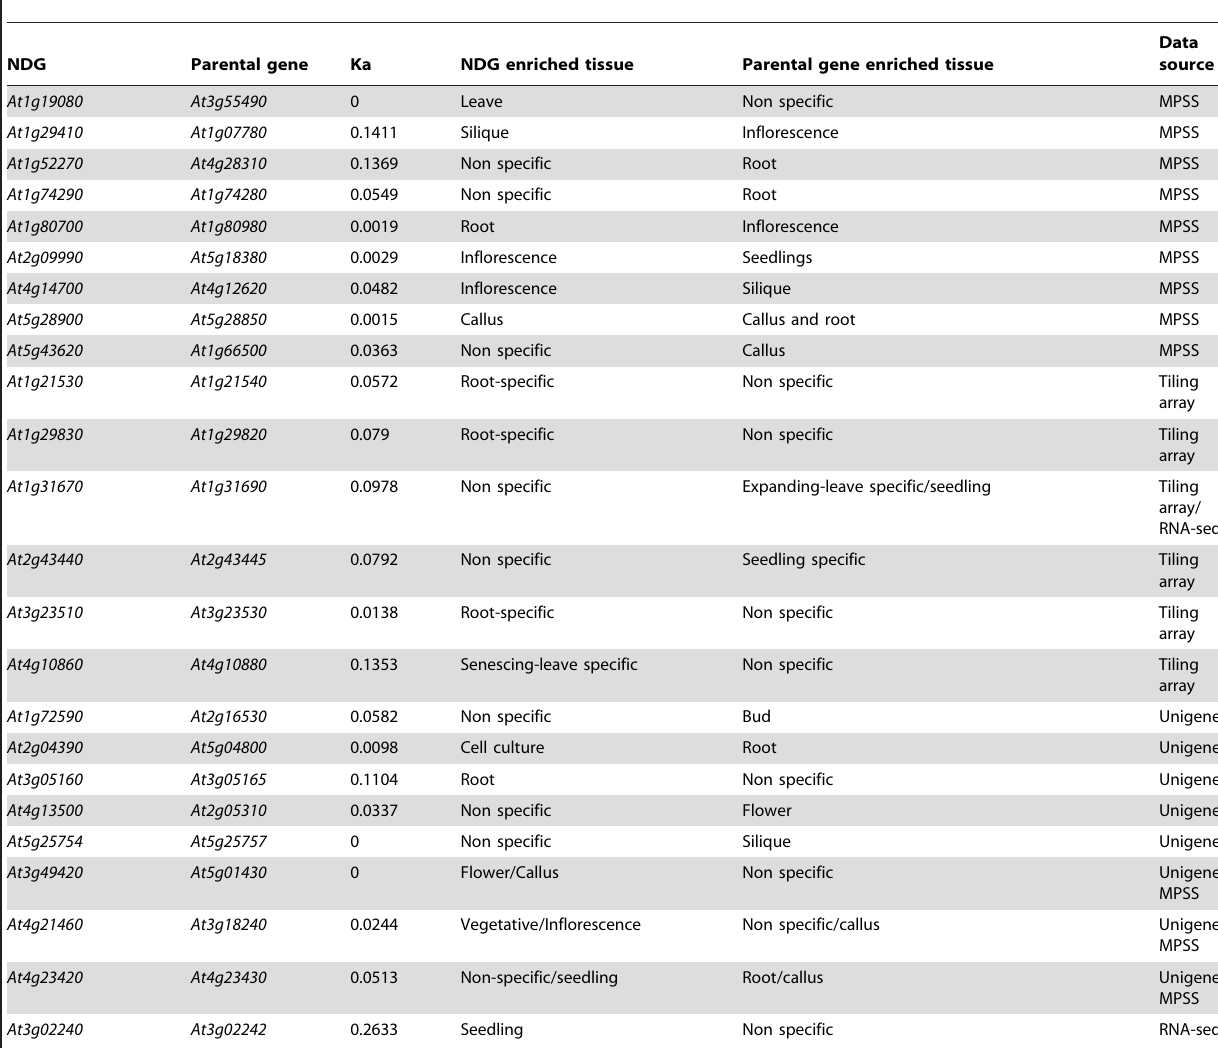
Table 4. The 24 paralog pairs having differential expression pattern between NDGs and parental genes.